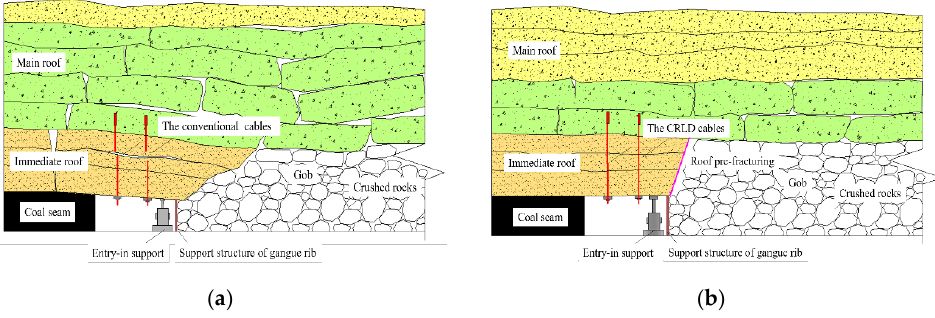
Figure 1. Principle of the GERRF method: ( a ) No roof pre-fracturing; ( b ) With roof pre-fracturing.